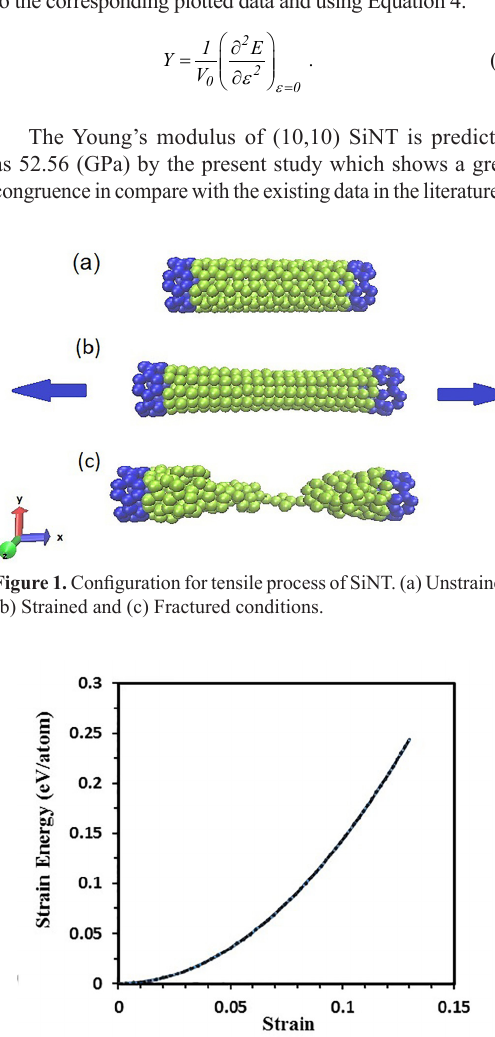
Figure 2. Strain energy values of (10,10) SiNT as a function of the axial tensile strain from MD